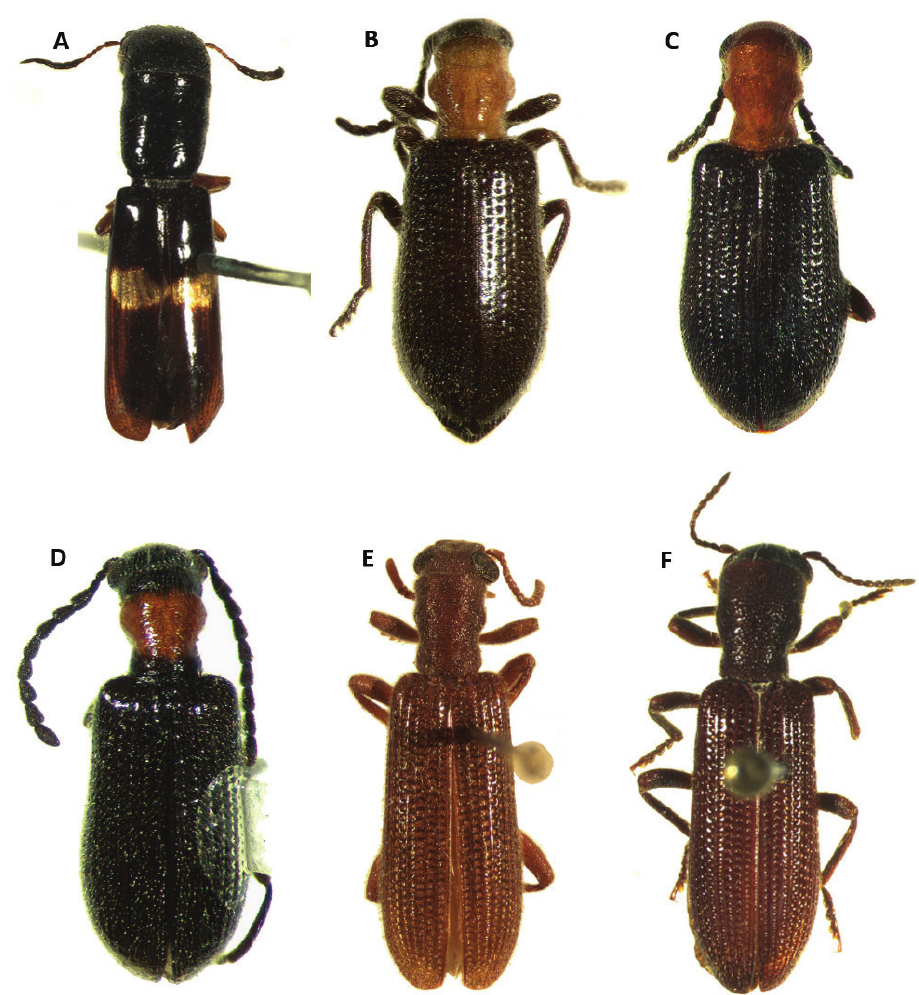
Figure 3. Habitus of: A Cylidrus abdominalis B Cymatoderella collaris C Cymatoderella morula D Cyma- toderella patagoniae E Lecontella brunnea F Lecontella gnara . tween these two entities. The fasciae observed in individuals examined under the name C. fasciatus display slight differences in shape, color, and pattern (Figs 3A, 5D). These fasciae can range from dark testaceous to almost albus, and can extend from the elytral suture to the epipleural fold, to only a pair of spots on the median region of the elytral disc. Specimens of C. abdominalis examined here are consistent with this variation. Re- maining characters were not variable for material of both species. Head, thorax, elytral fuscus; legs, mouthparts and abdomen testaceous; antennomeres 1-5 dark testaceous, antennomeres 6-11 fuscus. Each elytron with a median,